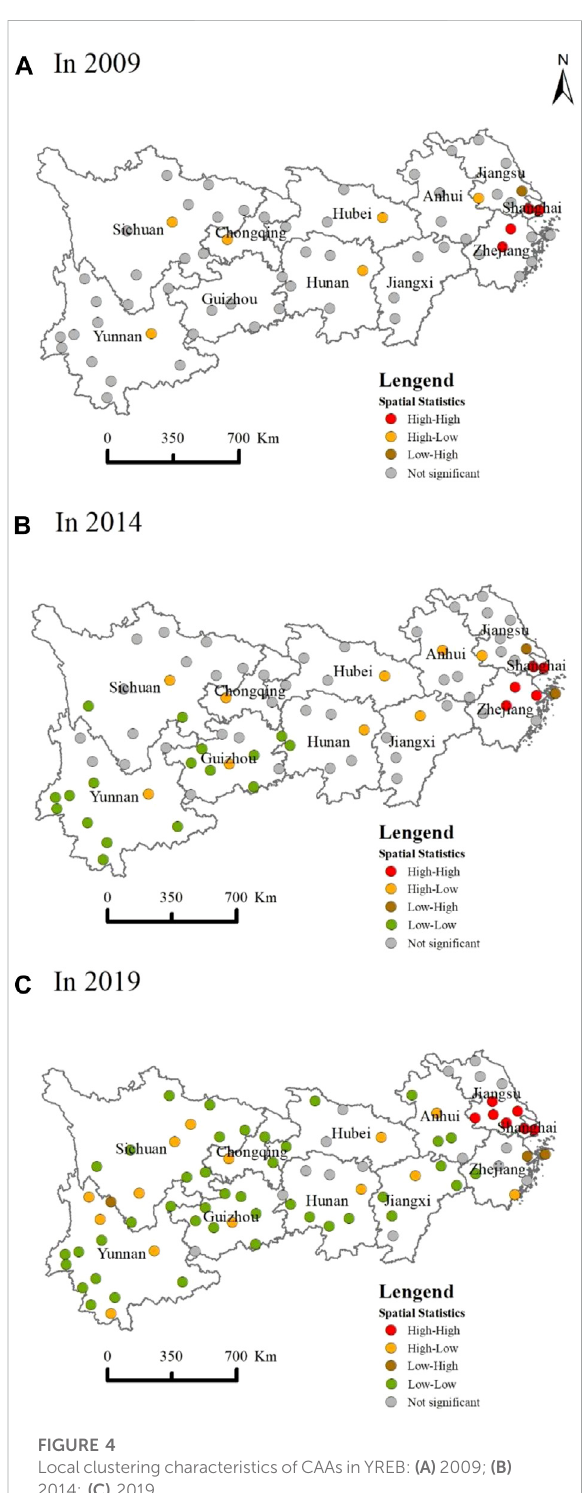
FIGURE 4 Localclustering characteristicsofCAAsinYREB: (A) 2009; (B) 2014; (C)